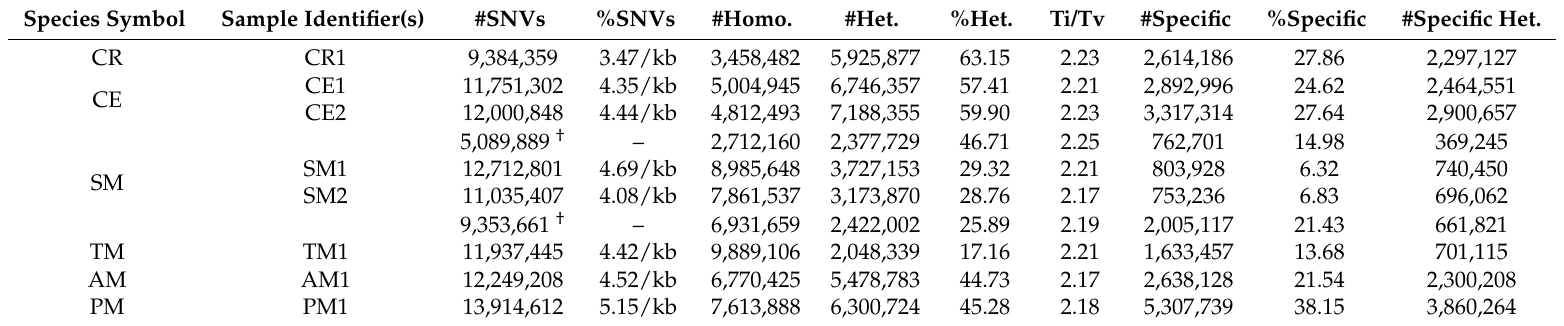
Table 2. SNV information for each analyzed macaque (see species symbol and sample identifiers in Table 1) including the total number of SNVs, the number of heterozygous (het.) or homozygous (homo.) SNVs, and the number of specific SNVs. Species